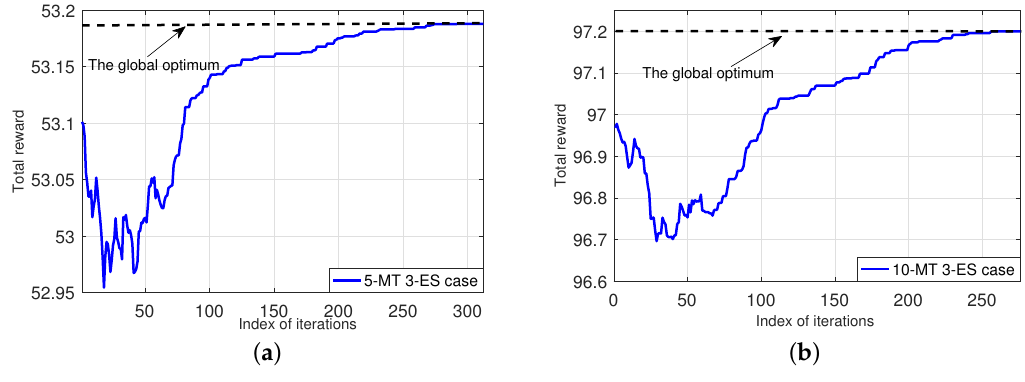
Figure 5. Convergence of our Algorithm 6. ( a ): a 5-MT and 3-ES case; ( b ): a 10-MT and 3-ES